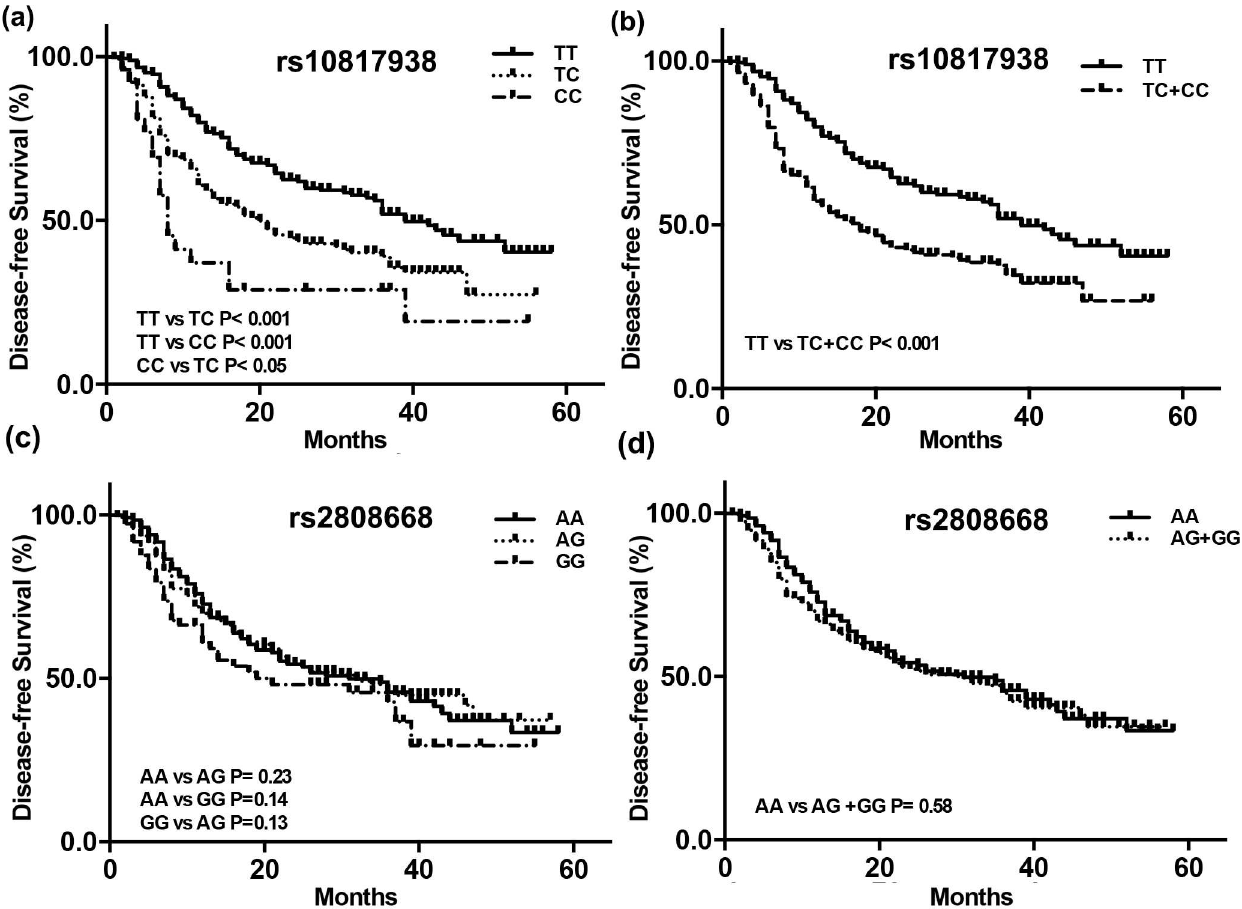
Fig 1. Kaplan-Meirsurvivalcurves; Kaplan-Meir survivalcurves for OSCC patientswith rs10817938(a, b) and rs2808668 (c, d) polymorphisms.The XPA rs10817938polymorphism was correlatedwith the disease-freesurvivalin OSCC patient,but not